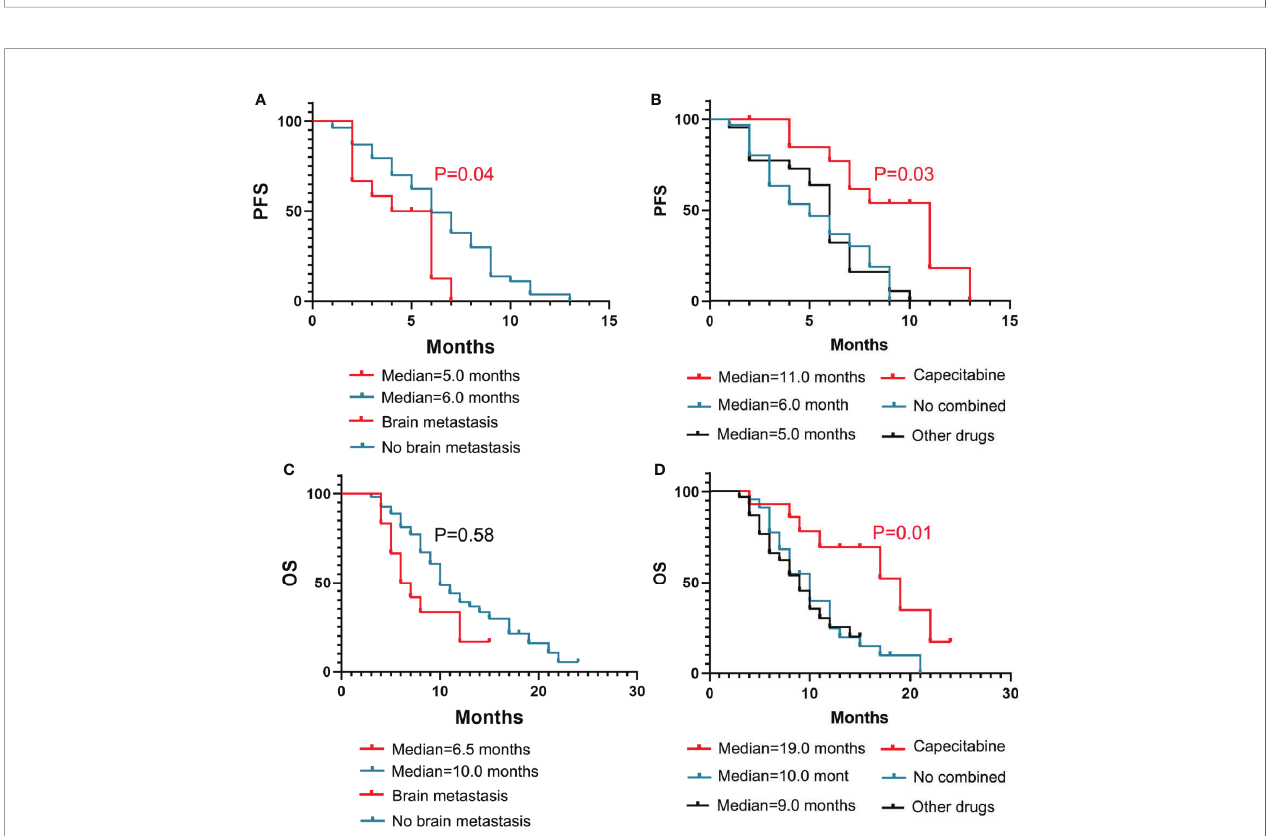
FIGURE 3 | Kaplan – Meier estimates of PFS and OS with different in fl uencing factors. Brain metastasis (A, C) and different drug regimens (B, D)